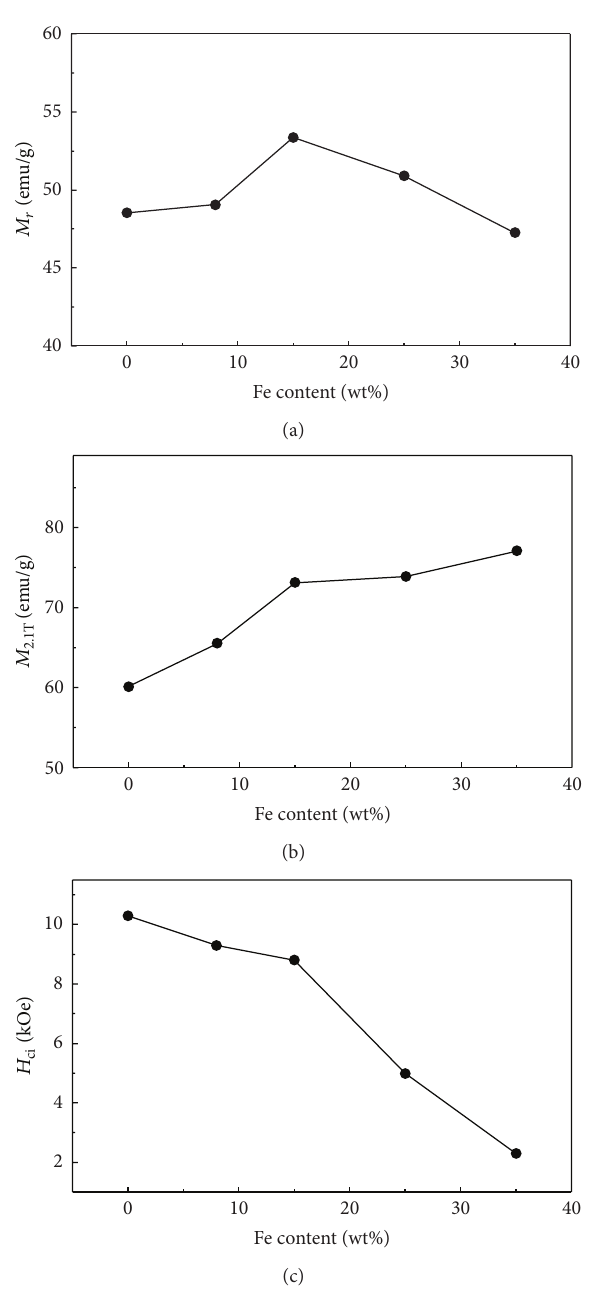
Figure 3: Magnetic properties of (Sm,Pr)Co 5 /Fe nanocomposites with different Fe contents.